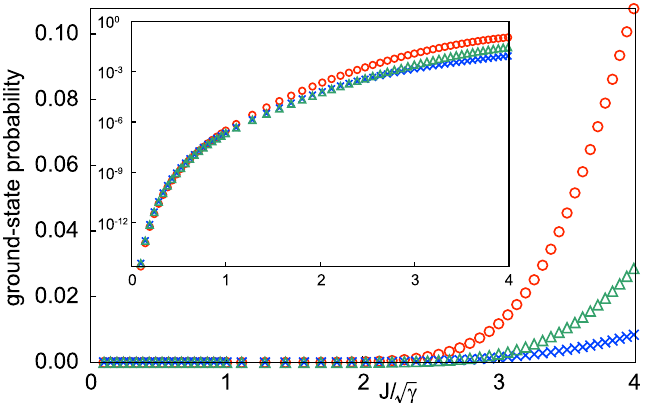
Figure 5: Ground-state probability for ˆ H the same as in Fig. 3. (Inset) Logarithmic